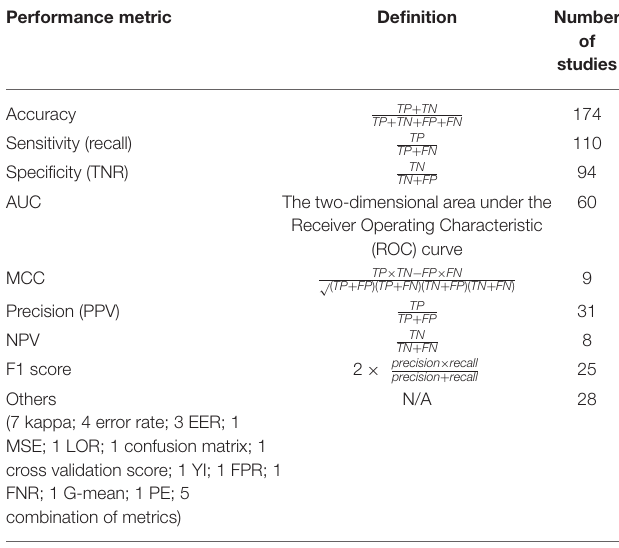
TABLE 3 | Performance metrics used in the evaluation of machine learning models.